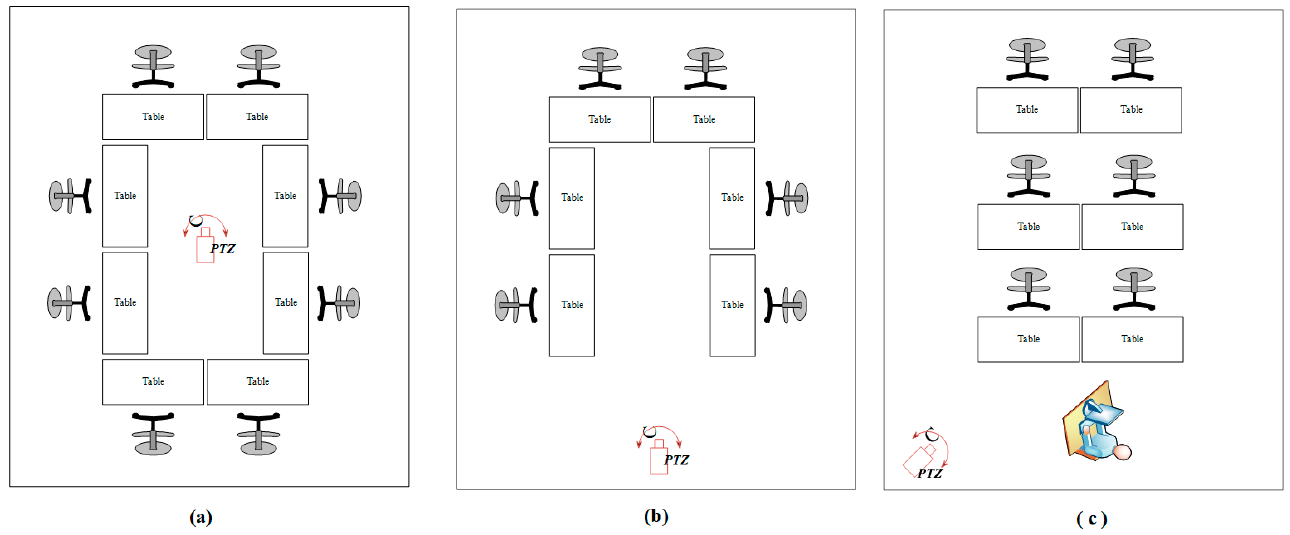
Figure 5. PTZ panorama use-case demonstration. Camera is placed in ( a ) center, ( b ) side, and ( c ) corner.